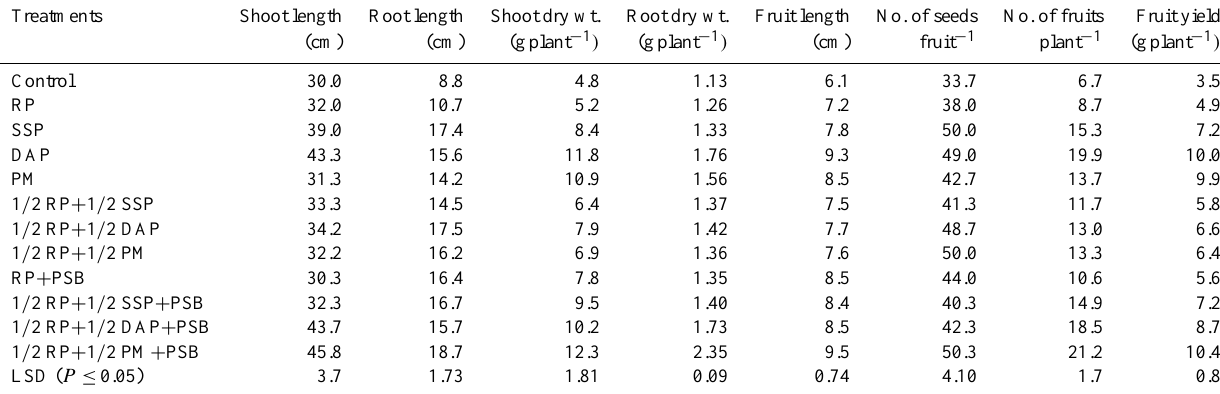
Table 4. Effect of soluble P fertilizers and insoluble rock phosphate (RP) applied alone or in combination with phosphate-solubilizing bacteria (PSB) and poultry manure (PM) on the growth and yield characteristics of chilli ( Capsicum annuum L.) grown in pots under greenhouse conditions at Rawalakot Azad Jammu and